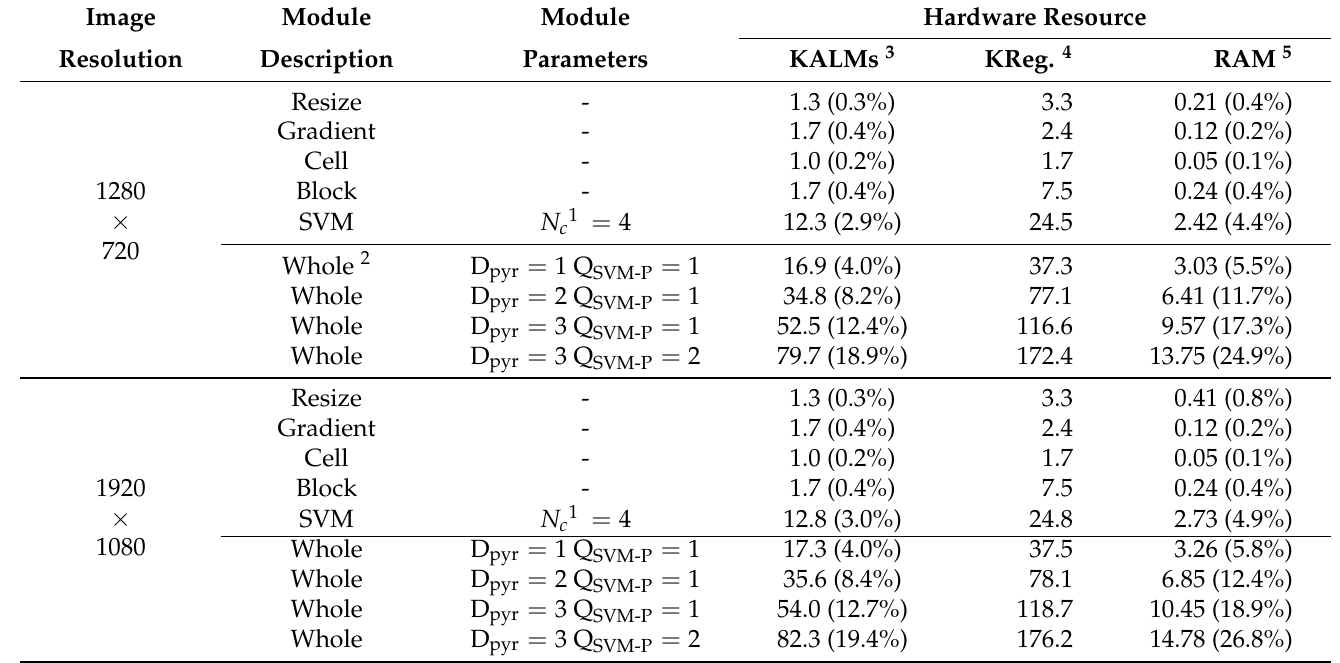
Table 2. Hardware resource of the PD system.